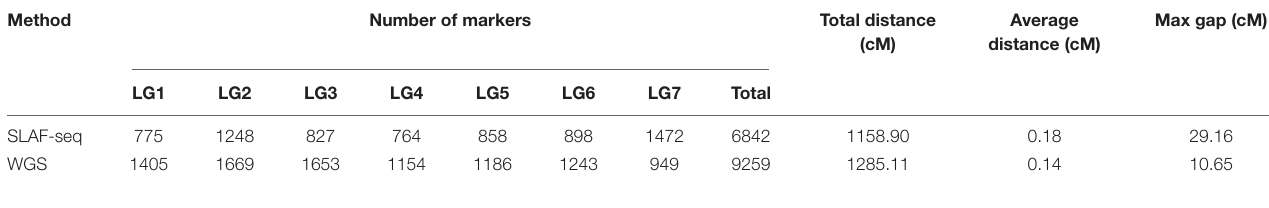
TABLE 6 | Comparison between maps constructed by the specific locus amplified fragment sequencing (SLAF-seq) and whole-genome sequencing (WGS) methods across linkage groups (LG). Method Number of